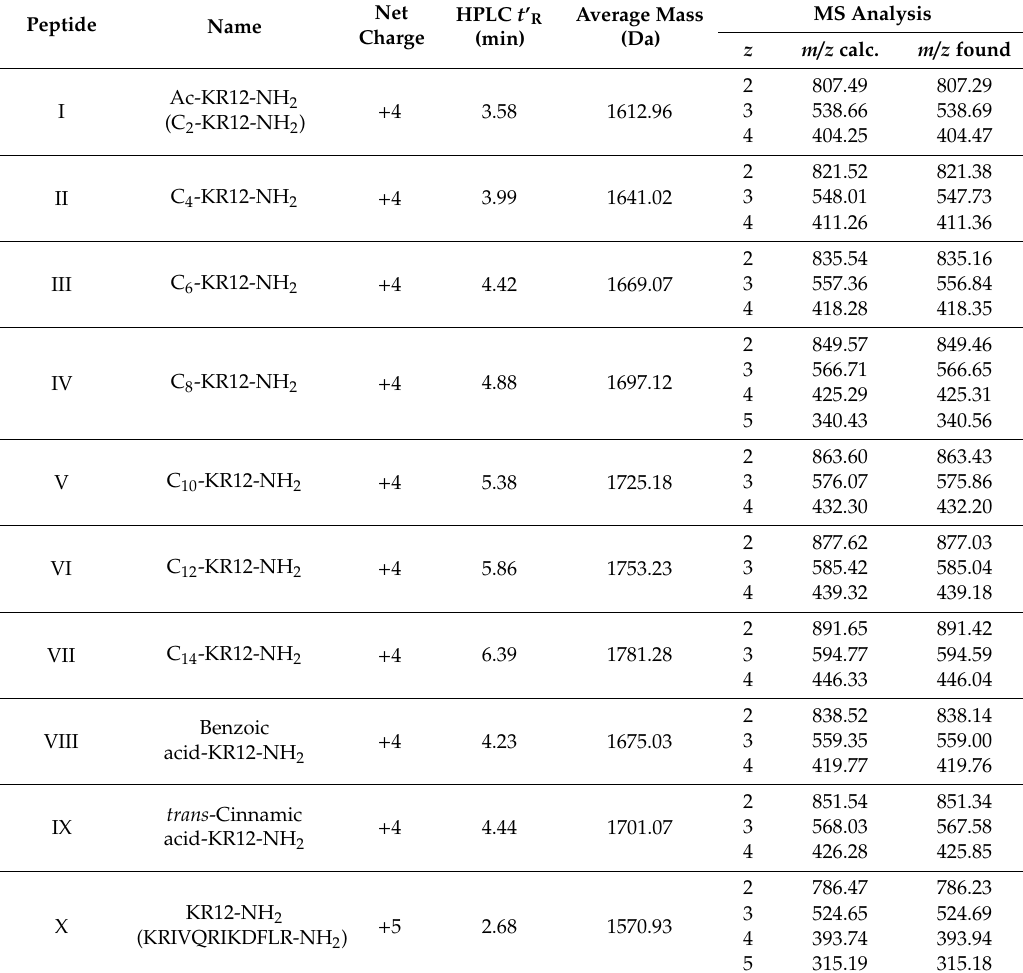
Table 1. Characteristics of the